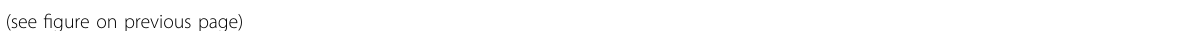
Fig. 2 Cytotoxicity induced by BSO and DPI combinatory treatment in highly metastatic pancreatic cancer cells. A Total cellular glutathione (GSX), including reduced and oxidized glutathione, was measured after 72 h of BSO treatment at 0, 50, or 100 μ M in L3.6pl cells by spectrophotometry. B L3.6pl cells were treated with DPI alone (1 or 3 μ M), BSO (100 μ M) alone, or BSO (100 μ M) and DPI (1 or 3 μ M) for 72 h. Cell morphology and population growth were compared under a light microscope. Scale bar, 200 μ m. C L3.6pl cells were treated as described in B for 72 h. The cell death rate was measured by fl ow cytometry using annexin-V and PI as probes and expressed as a percentage of the annexin-V/PI positive cells. L3.6pl cells without any treatment served as controls. D L3.6pl cells were treated with a combination of 3 μ M DPI and 100 μ M BSO in the presence or absence of 2 mM NAC for 72 h. Cell death rates were determined by Annexin V/PI double staining. E Statistic analysis of cell death rate of L3.6pl cells treated in D . Data are mean ± SD of three independent experiments with Student ’ s t test. *** p < 0.001, **** p <